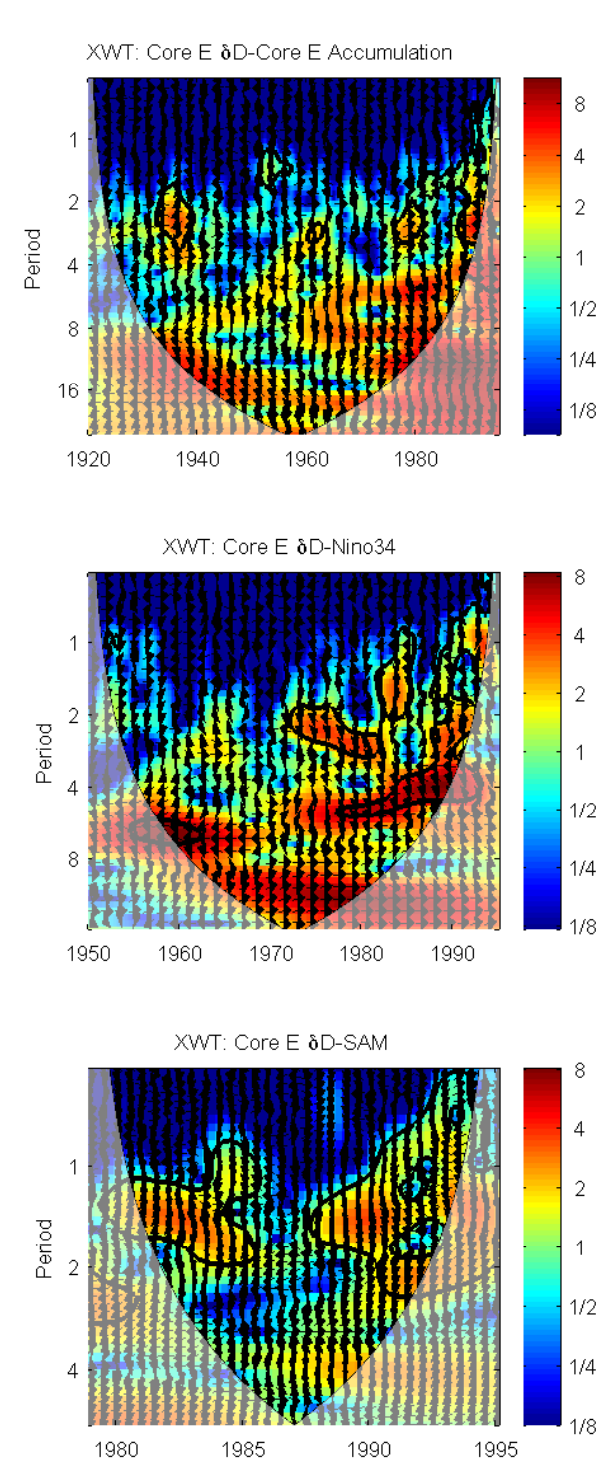
Figure A1. Top panel: core E δ D and core E net accumulation XWT from 1657 to 1995. Middle panel: core E δ D and Niño 3.4 XWT from 1950 to 1995. Bottom panel: core E δ D and SAM XWT from 1979 to